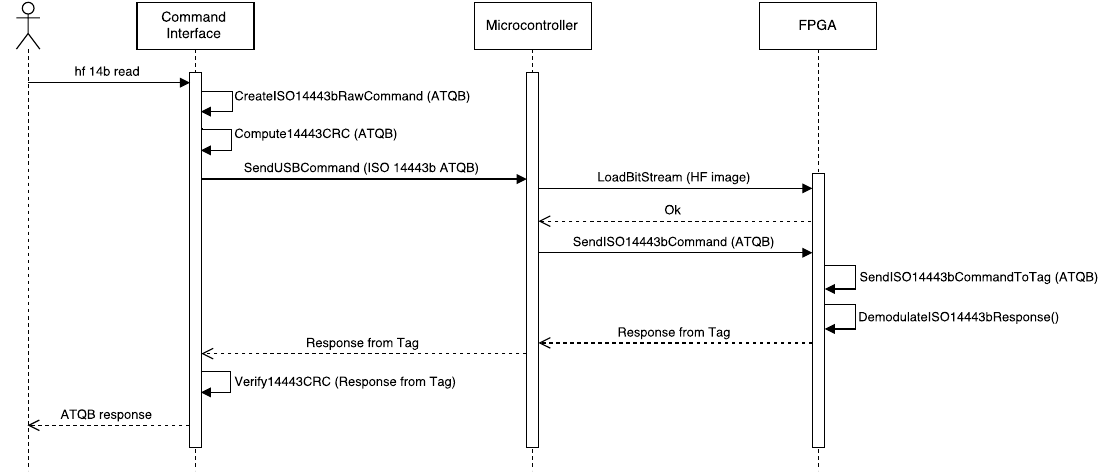
Figure 12. Simplified sequence diagram of the successful identification of an ISO/IEC 14443-B tag.